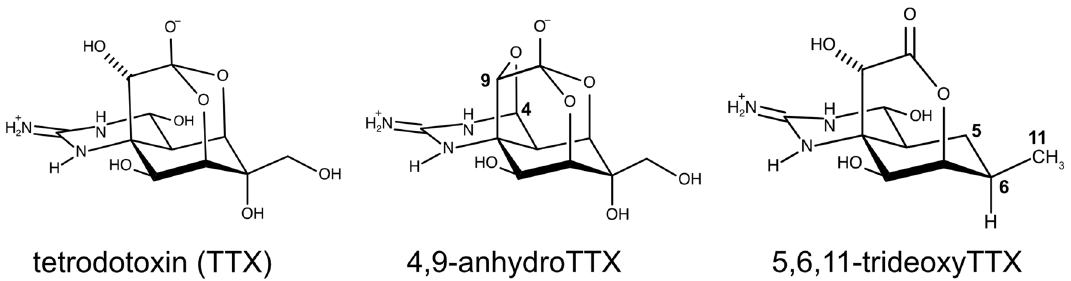
Figure 1. Molecular structures of tetrodotoxin and its analogs used in this